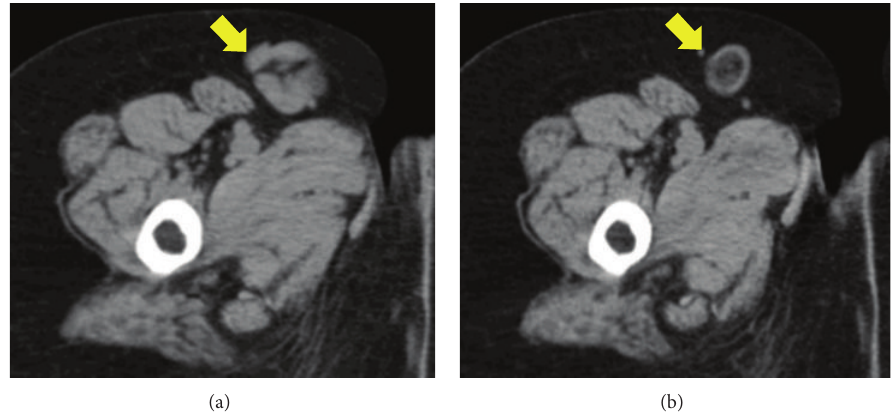
Figure 4: Change in lymph node size by TCZ therapy. Generalized lymphadenopathy was observed before TCZ therapy (left panel, right inguinal area) but it regressed rapidly with central necrosis after TCZ therapy (right panel, right inguinal